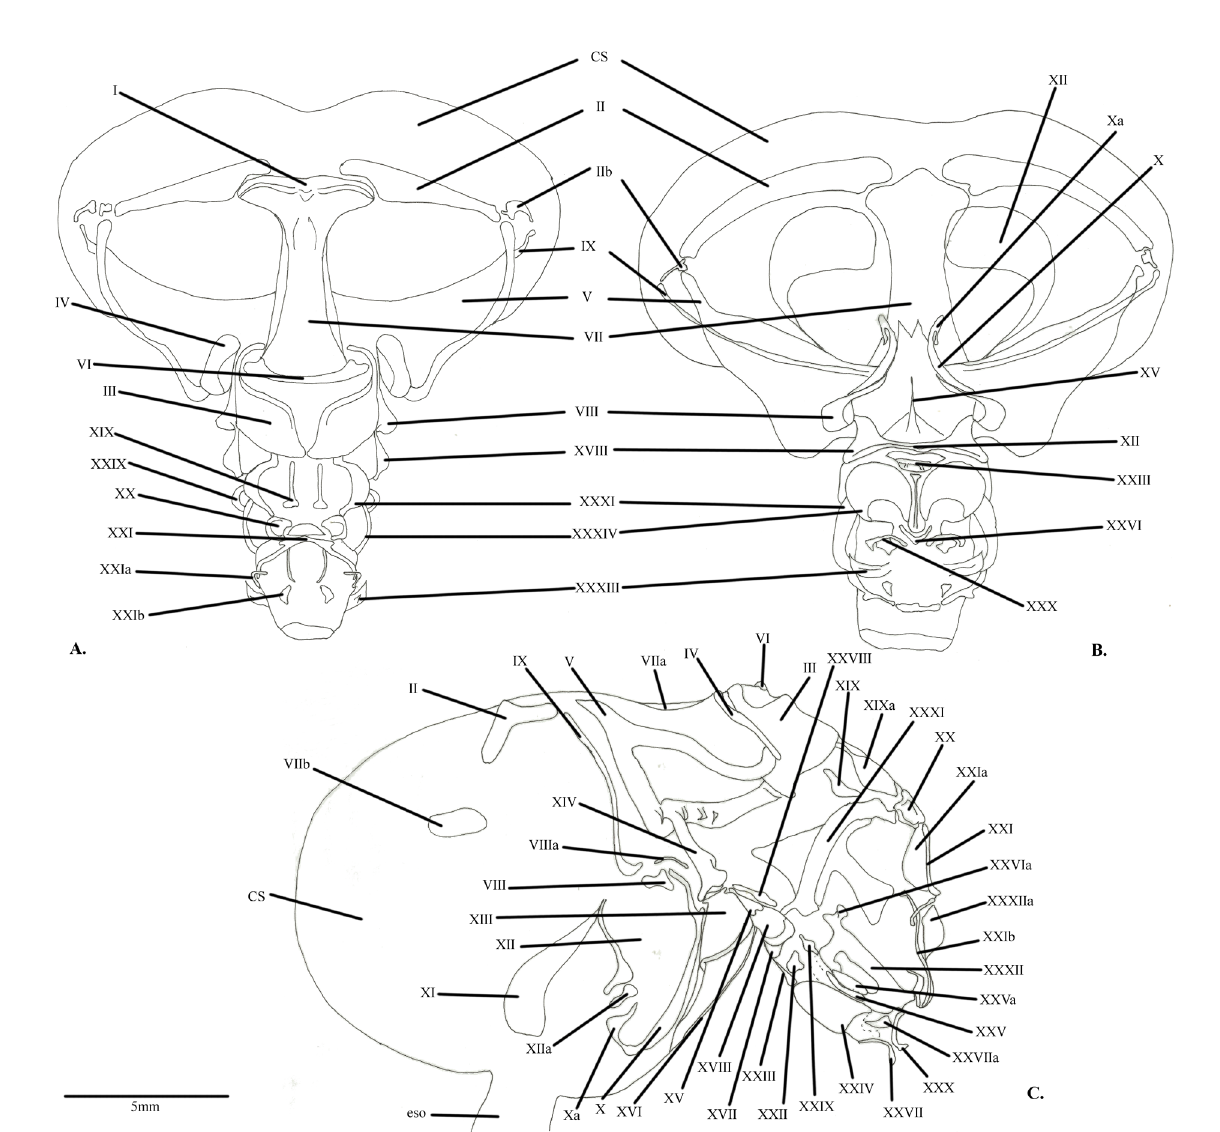
Figure 1. Dilocarcinus pagei Stimpson, 1861, cardiac and pyloric chambers of the foregut. A, Dorsal view; B, ventral view; C, lateral view. Abbreviations: CS, cardiac sac; eso, esophagus; see Tab. 2 for the nomenclature of the